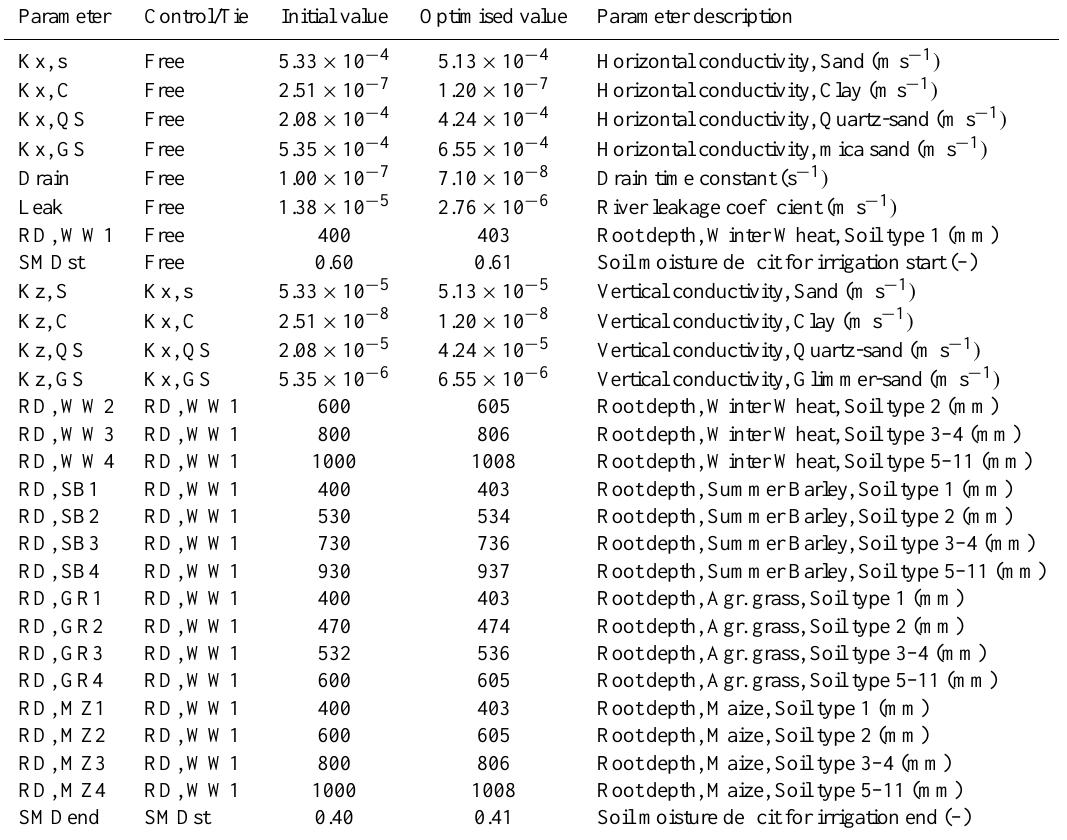
Table 3. Initial and optimised parameter set as a result of model calibration using